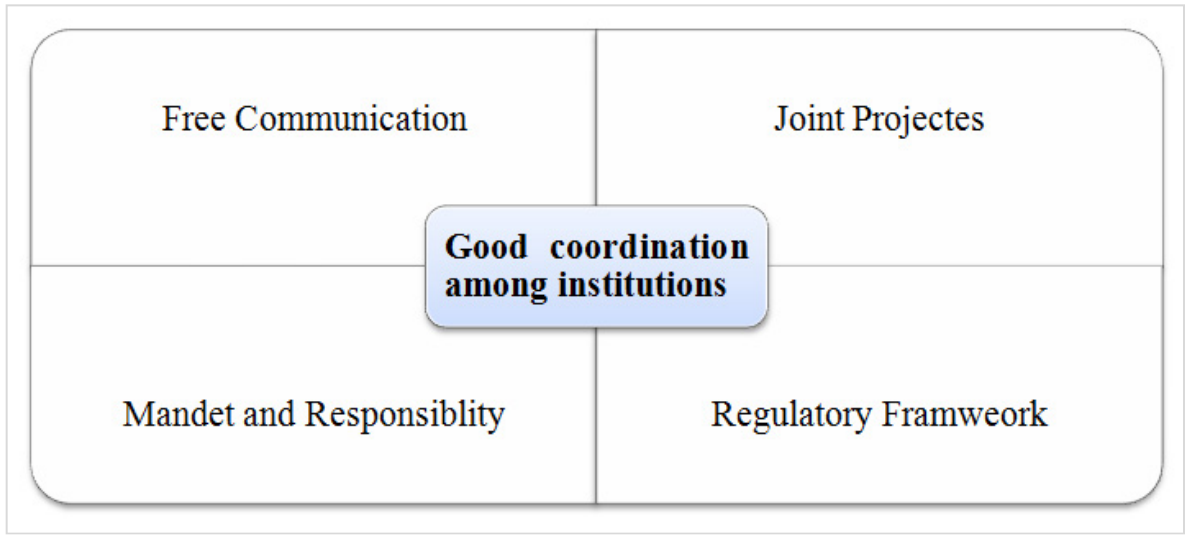
Figure 7. Alternatives for promoting good coordination among institutions.